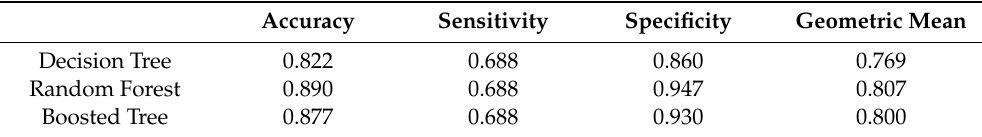
Table 5. Performance measures for classification of non-parallel turns on test data set.